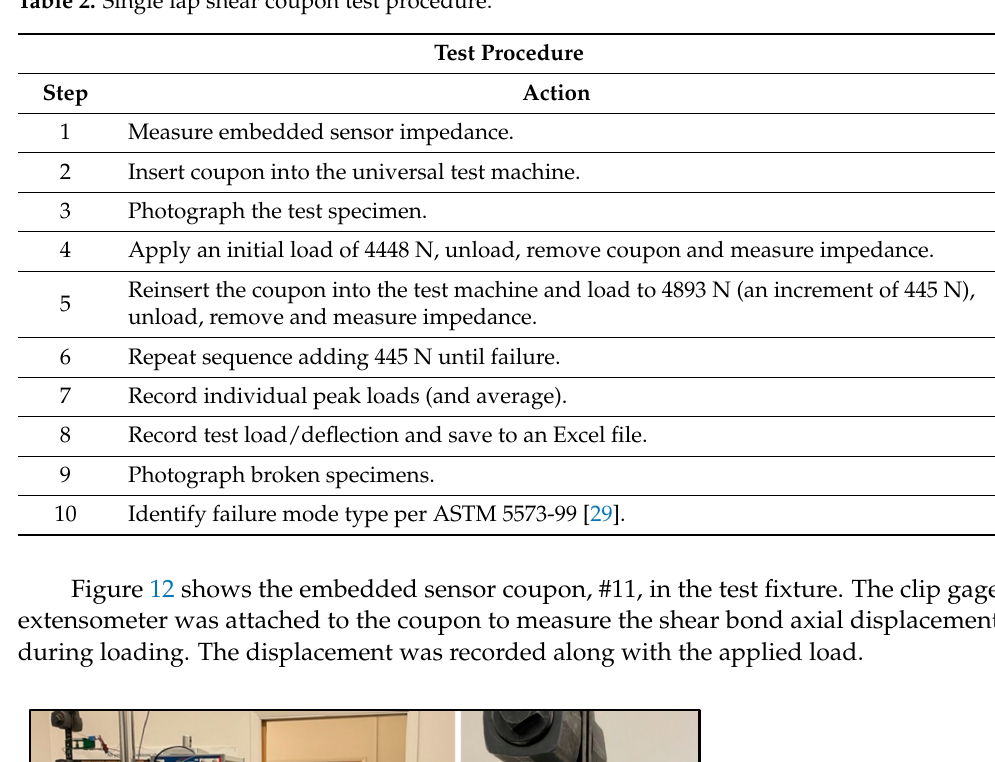
Table 2. Single lap shear coupon test procedure.